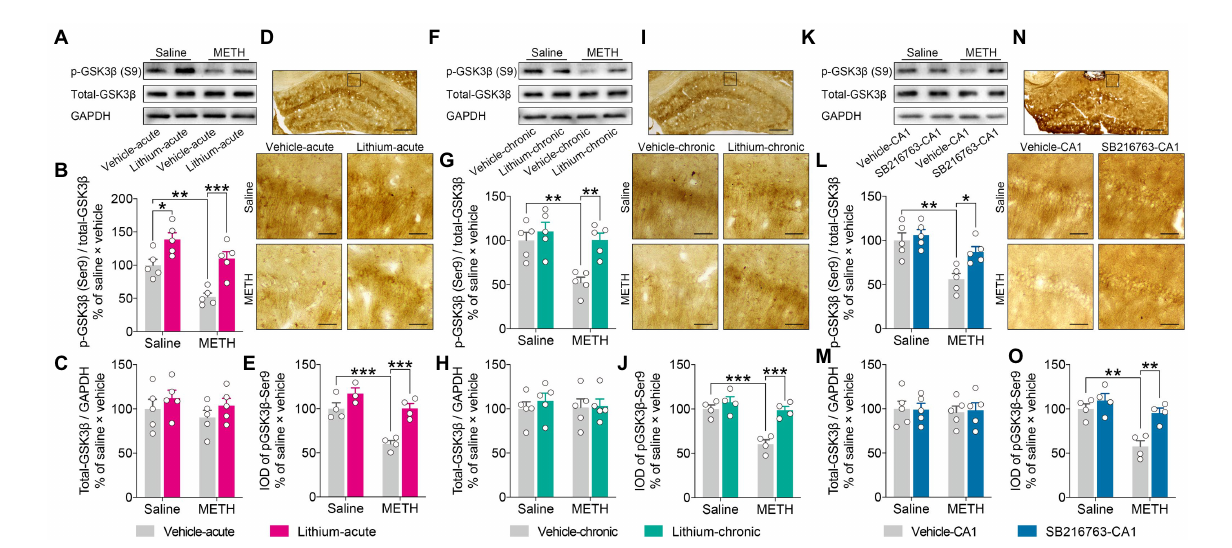
FIGURE 7 Effects of GSK3 β inhibition on abnormal GSK3 β activity in the adult DHP CA1 subregion induced by adolescent METH exposure. Acute systemic intervention (A–E) , chronic systemic intervention (F–J) , and chronic intervention within CA1 (K–O) restored the adolescent METH exposure-induced increase in the GSK β activity of the DHP CA1 subregion in adulthood. Representative western blot of total and phosphorylated GSK3 β in the DHP CA1 extract (A,F,K) . The relative changes in the ratio of phosphorylation of residues Ser9 (indicative of inactive protein) (B,G,L) and the expression of total GSK3 β (C,H,M) were analyzed. Representative immunostaining of pGSK3 β -Ser9 in the DHP CA1. The boxes indicate regions shown at higher magnification in the lower panels; scale bars represent 250 μ m under low magnification and 50 μ m under high magnification (D,I,N) . The relative changes in the IOD of pGSK3 β -Ser9 in the DHP CA1 subregion were analyzed (E,J,O) . Data are presented as the mean +/ − SEM, each symbol represents the independent of a single animal; two-way ANOVA followed by the Bonferroni post hoc test; n = 5/group in western blot, n = 4/group in immunohistochemistry; * p < 0.05, ** p < 0.01, and *** p < 0.001, comparison between the two indicated